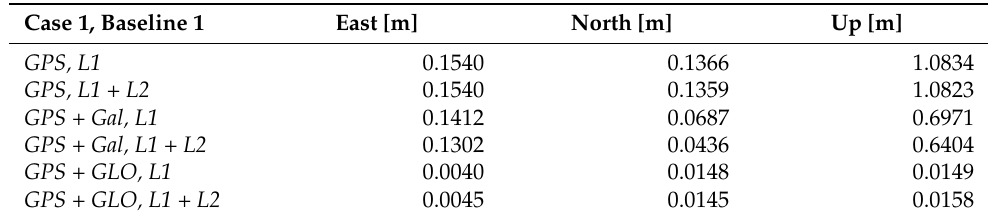
Table 8. Standard deviation from known position in the east, north, and up direction for PPK solutions using different constellations and frequencies during the jamming incident in Case 1, baseline